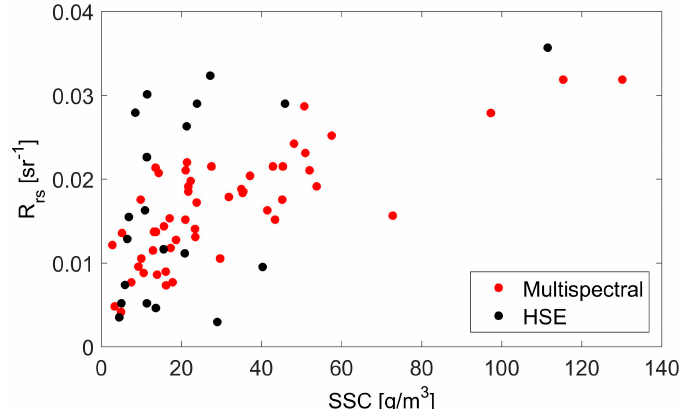
Figure 10. Hyperion Synthetic ETM+ (HSE) reflectance plotted as a function of SSC along with the multispectral data.